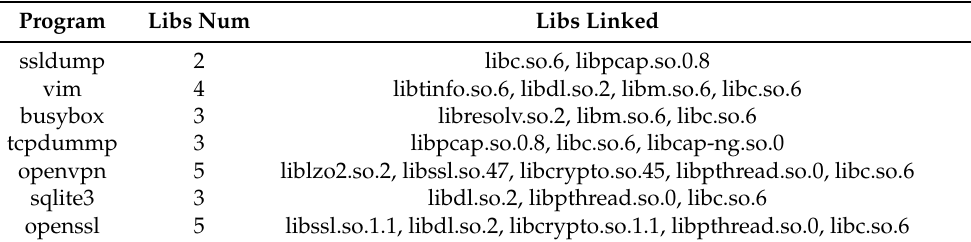
Table 2. Ubuntu datasets used for evaluating TPL